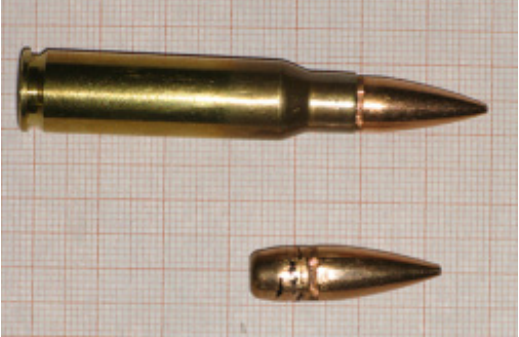
Figura 4: Banco di sostegno e sistema per la misura della velocità residua